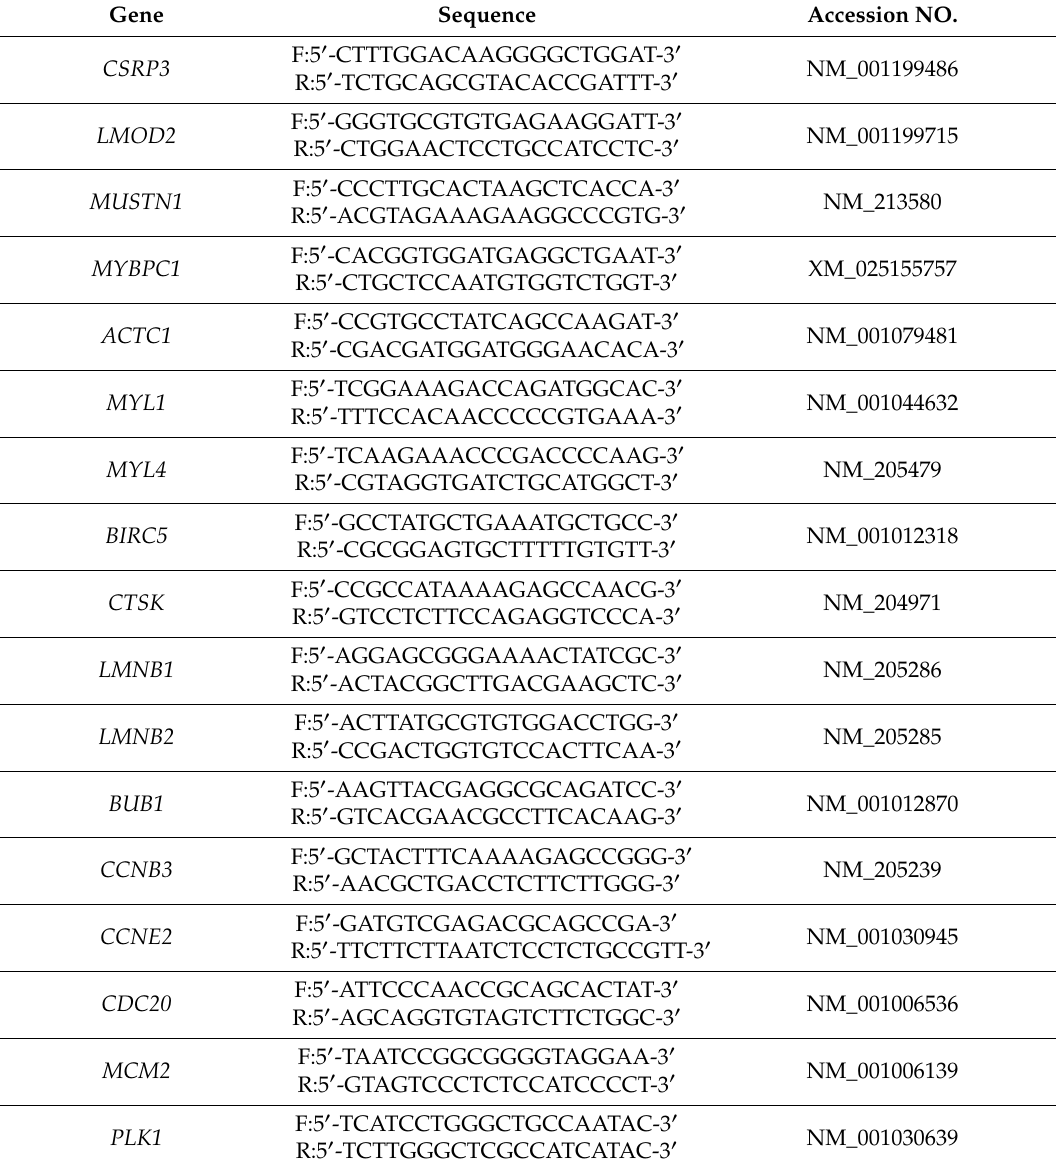
Table 2. The specific primers for Q-PCR in this